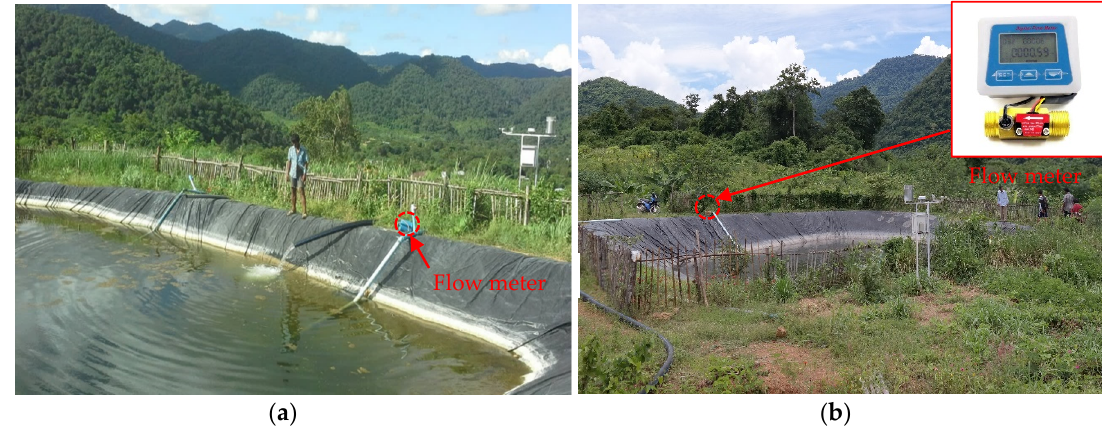
Figure 9. Water flows into the reservoir (photos by the authors): ( a ) Pongluek village; ( b ) Bangkloy village.